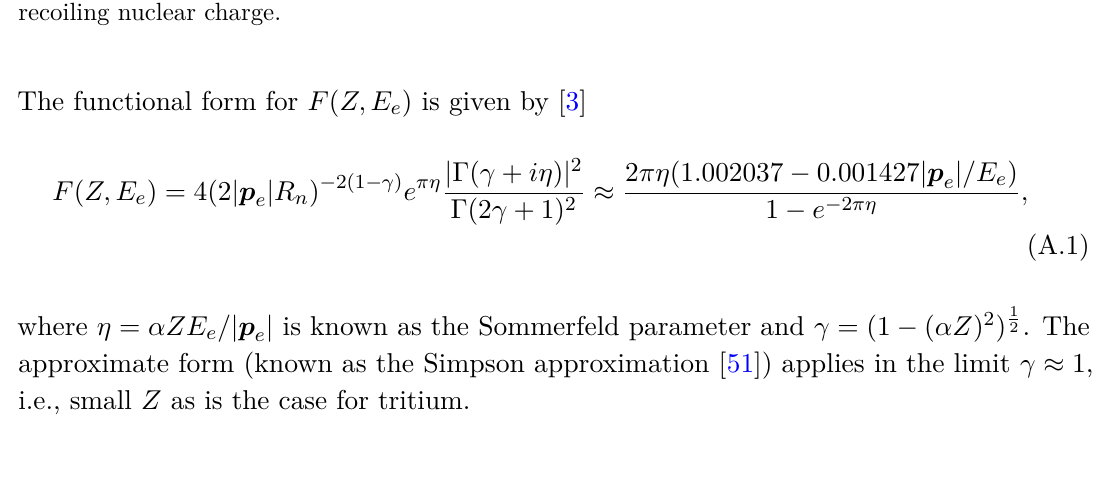
Figure 14 . Plots showing the effect of theoretical corrections on the differential spectrum. Upper left: radiative corrections. Upper right: orbital electron shielding. Lower left: scaling of the electric field and convolution of electron and neutrino wavefunctions, both within the nucleus. Lower right: recoiling nuclear